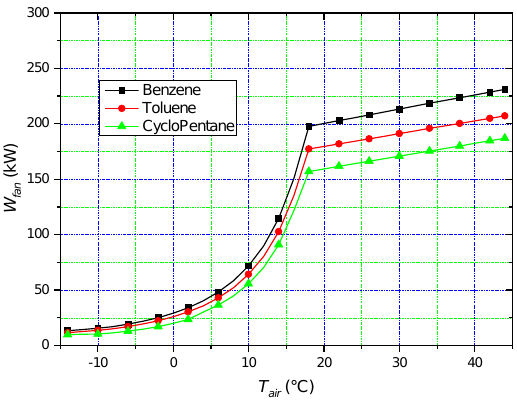
Figure 5. Power absorbed from condenser fan varying ambient temperature.